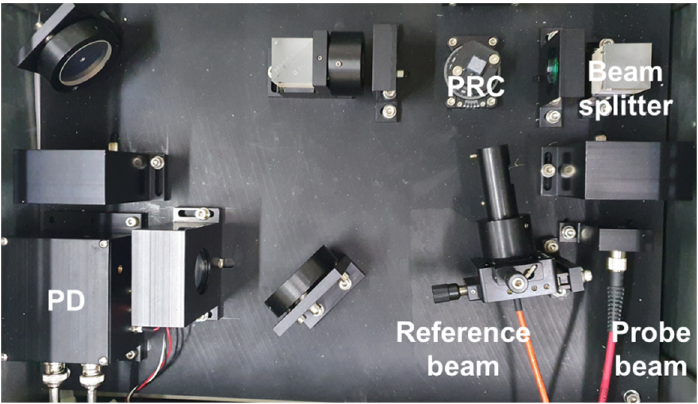
Figure 3. Schematic diagram for measurement of β parameter using laser-ultrasonic detection.